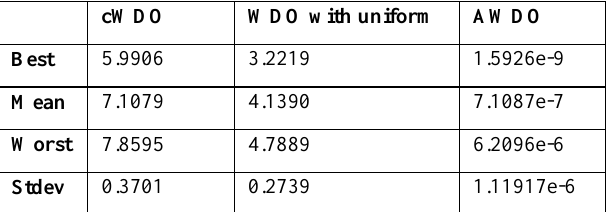
Table 5. Results of Rosenbrock in search space of [-30, 30]